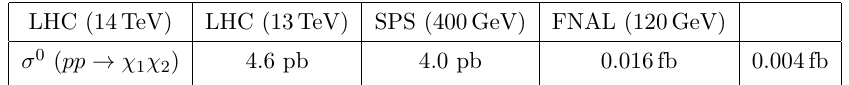
Table 5 . Cross-section for direct production in various high-energy proton beam experiments for M 1 + M 2 (cid:28) E cm for the e(cid:11)ective couplings (as de(cid:12)ned in eq. (2.2) and eq. (2.3)) chosen as g u = 2 = 3 ; g d = (cid:0) 1 = 3, with the operator scale of (cid:3) = 1